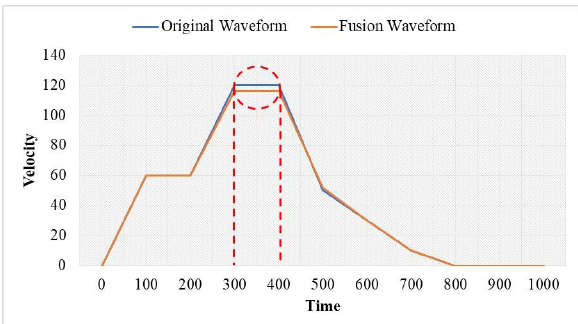
Figure 9: Simulation results of the system without filtering